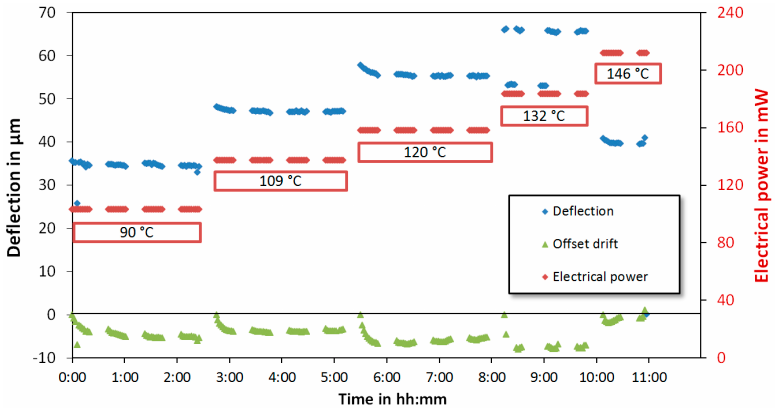
Figure 7. Dynamic characteristic of electrothermal actuators: Electrical input power, amplitude, offset drift and maximum operation temperature over actuation